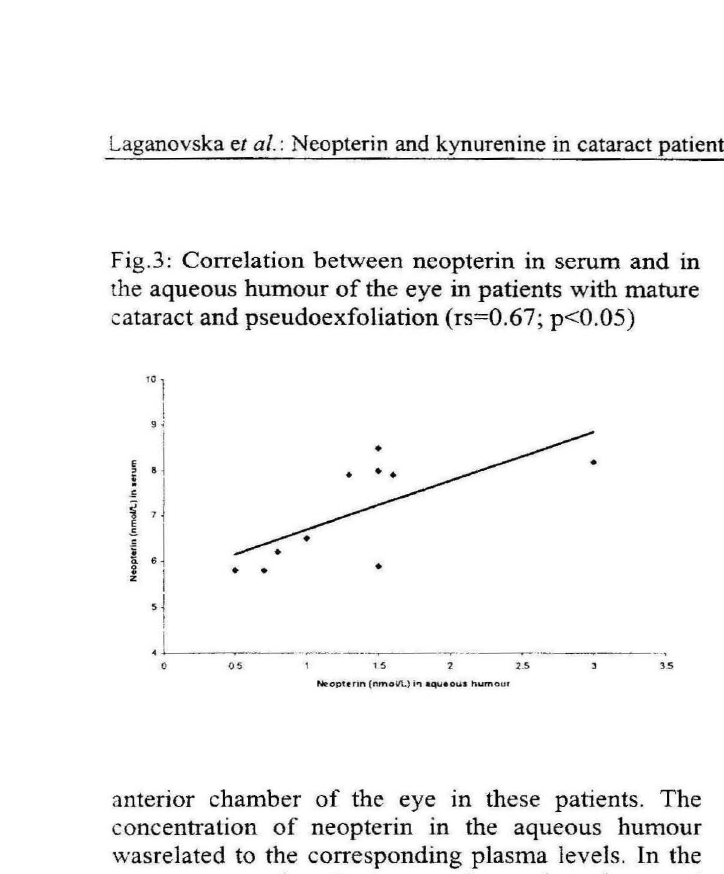
Fig.3: Correlation between neopterin in serum and in the aqueous humour of the eye in patients with mature cataract and pseudoexfoliation (rs=0.67;